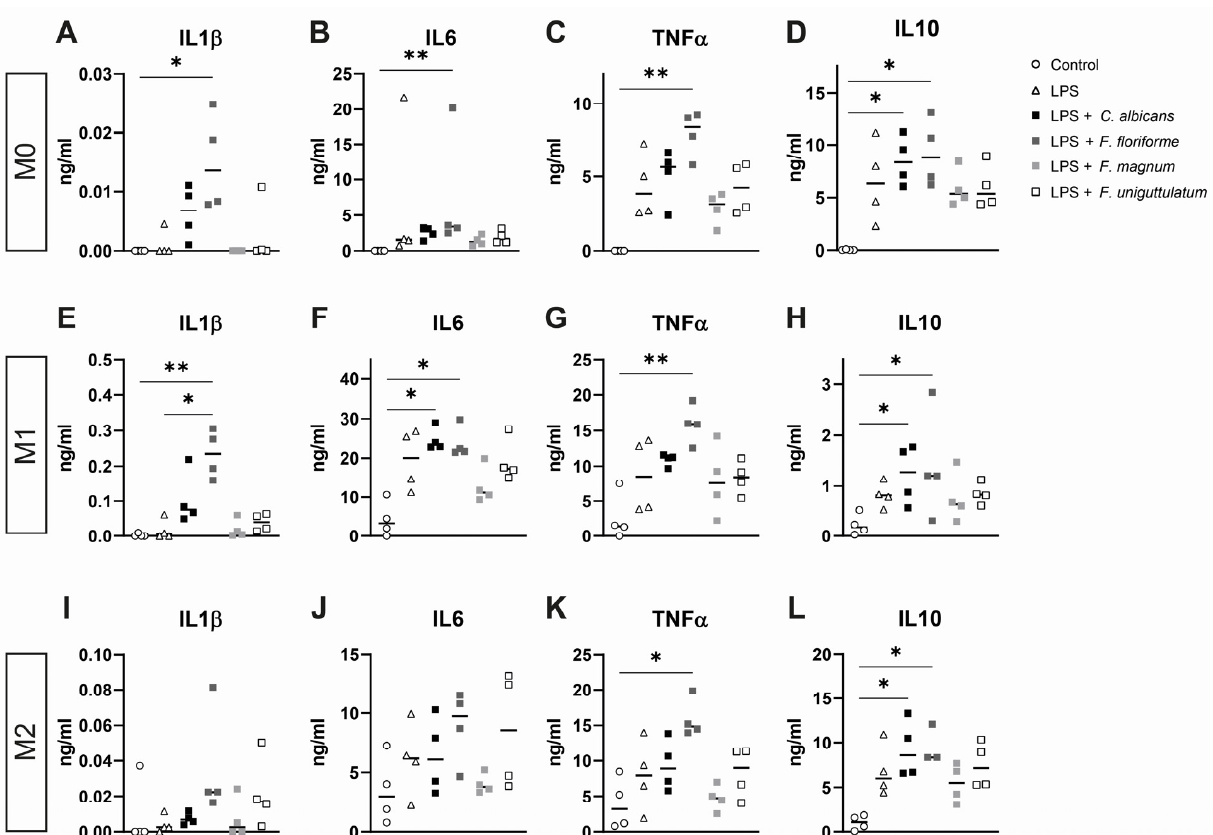
Figure 3. Cytokine release from different states of macrophages after pre-treatment with lipopolysaccharide and stimulation with Filobasidium species or Candida albicans . ( A – L ) Released cytokines by LPS pre-incubated monocyte-derived macrophages skewed into M0, M1, or M2 phenotype (( A – D ), ( E – H ), ( I – L ), respectively) stimulated with yeasts. All data represented as median and individual data points ( n = 3–4 donors). * p <0.05; ** p <0.01.